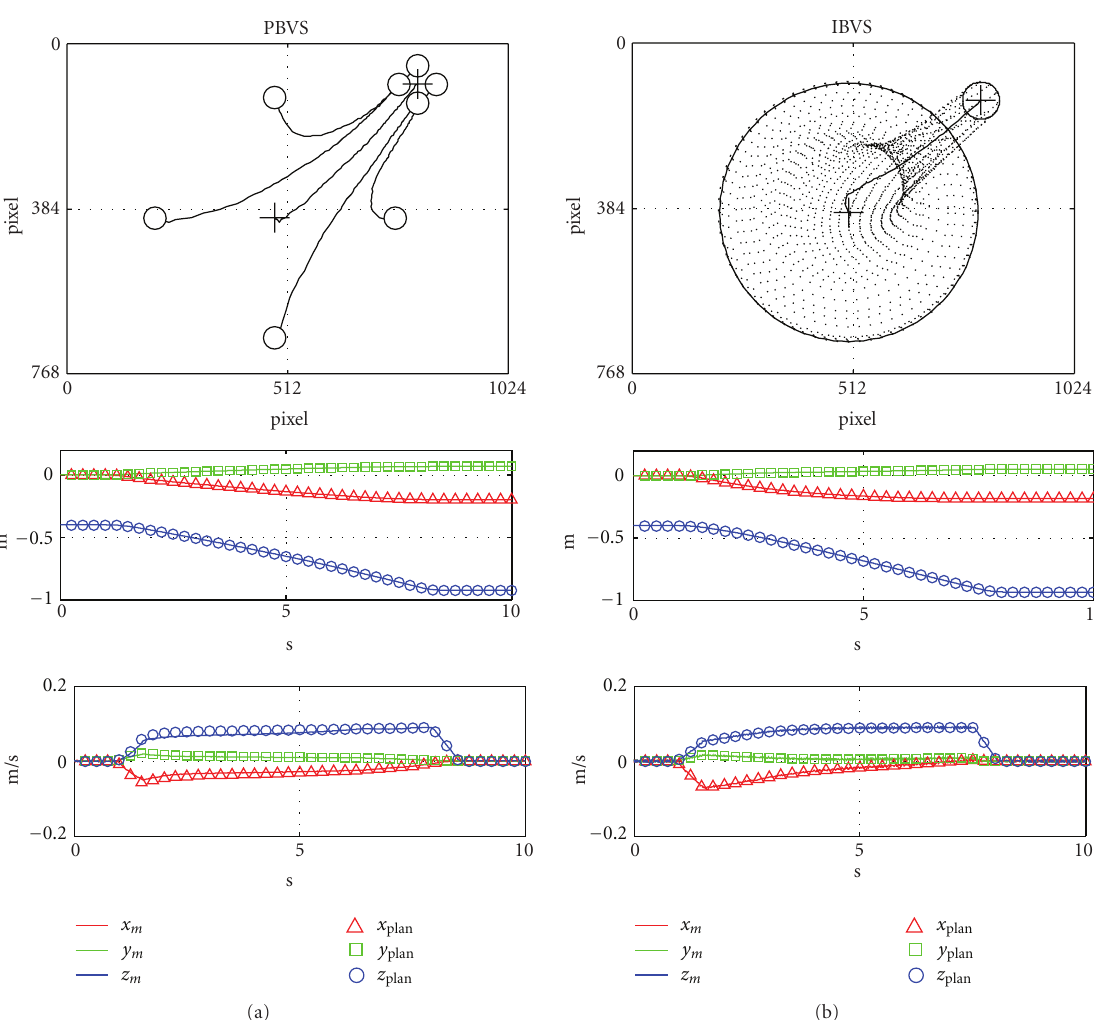
Figure 8: Slow tests ( v max = 10 − 1 m/s) with fixed